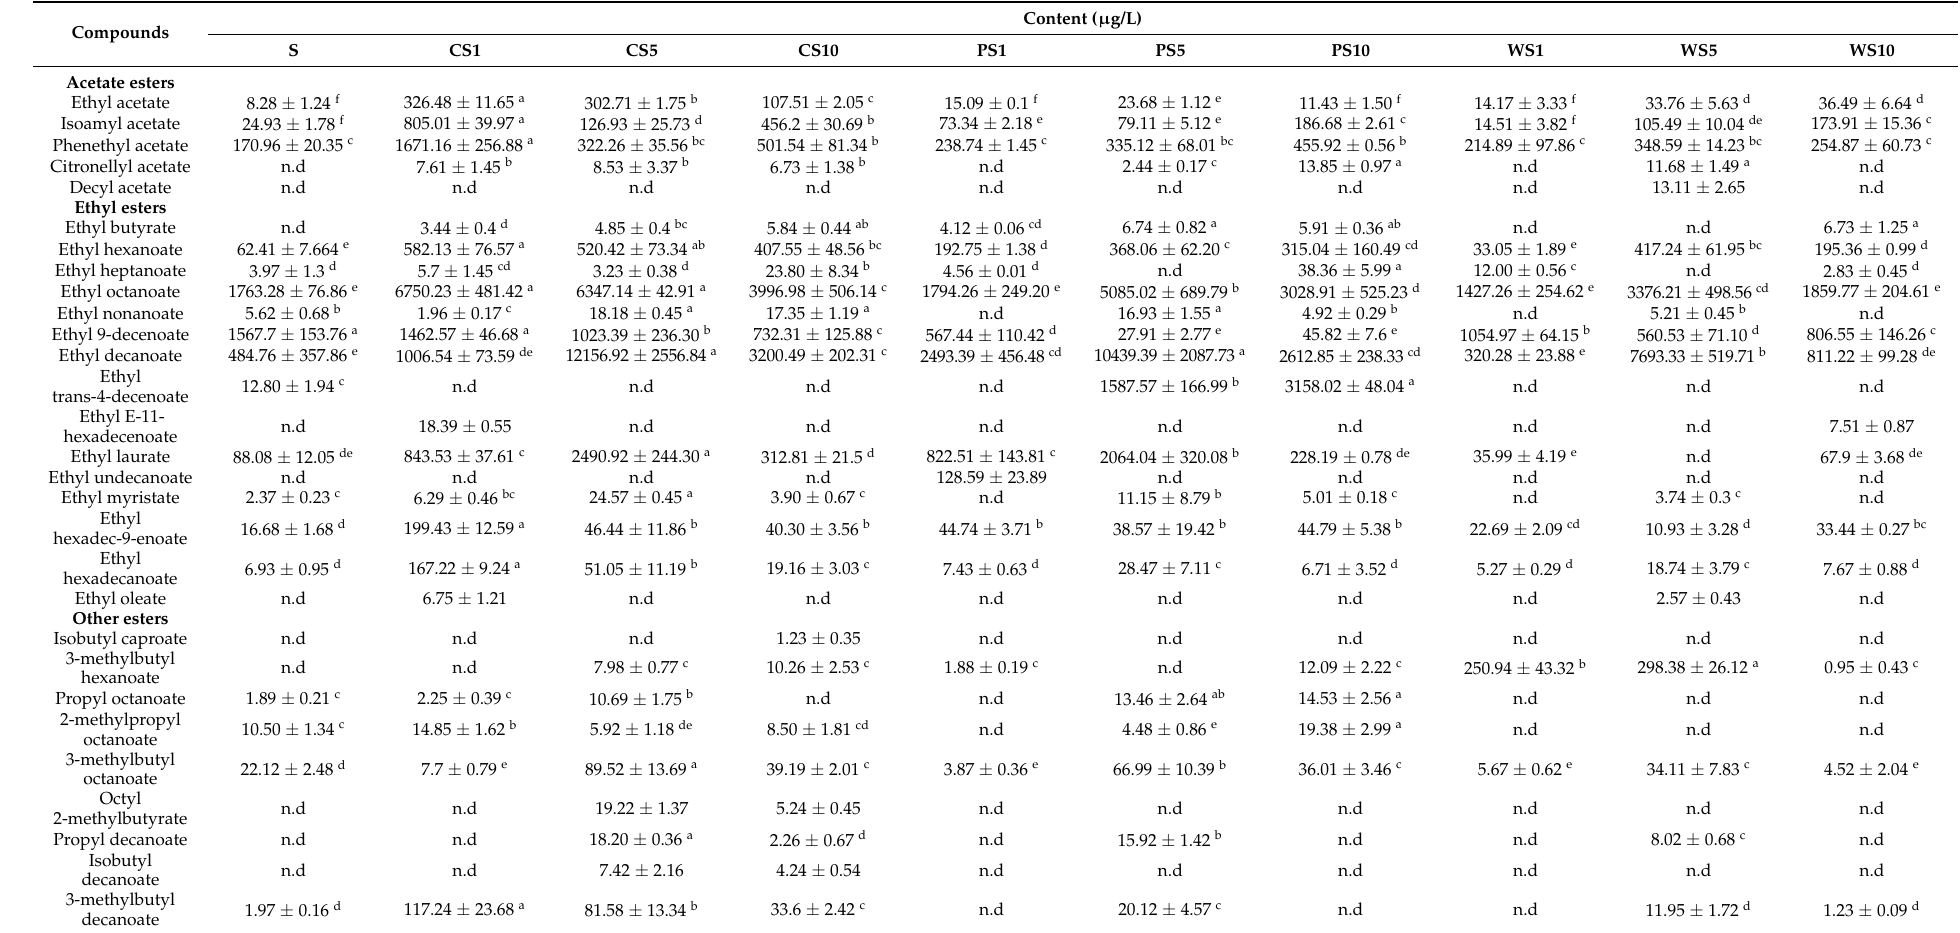
Table 1. Type and content of ester compounds identified in different ester-producing yeasts with S. cerevisiae NCUF309.2 at different ratios during simulated fermentation of blueberry